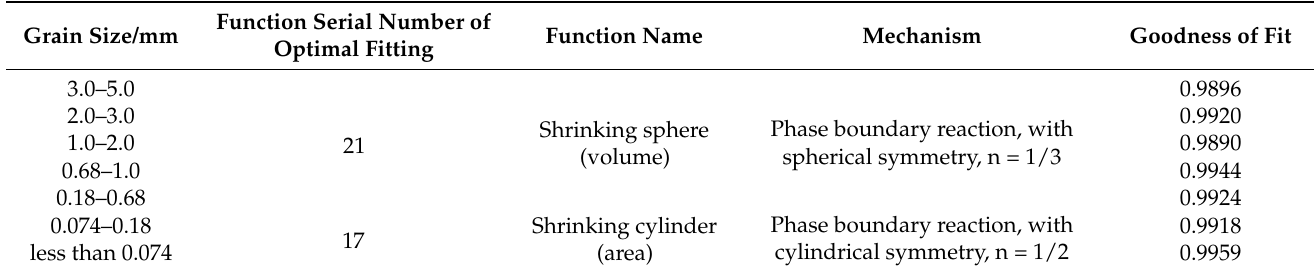
Table 3. The optimal fitting results of kinetic mechanism functions for limestone with different particle sizes.